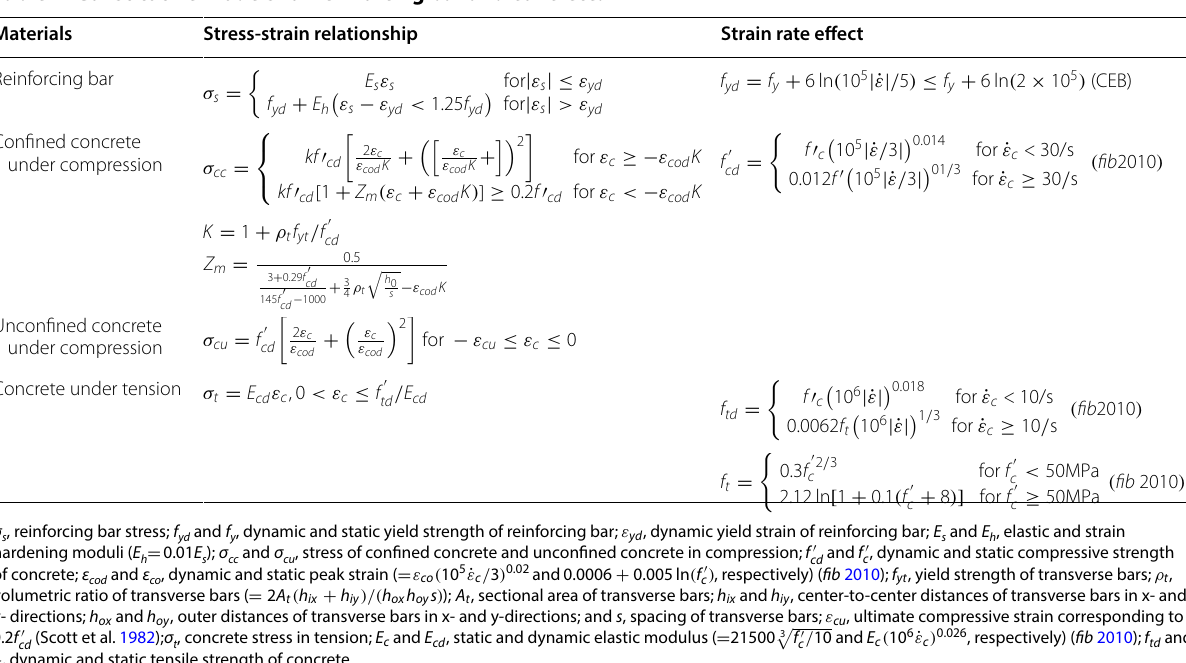
Table 4 Constitutive models for reinforcing bar and concrete.